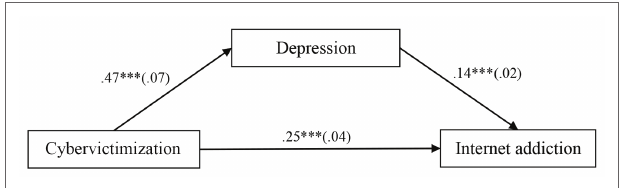
FIGURE 2 | Model of the mediating role of depression between cybervictimization and internet addiction (IA). Values are unstandardized coefficients (outside the brackets) and the standard error is enclosed in parentheses. Paths between gender, age, impulsivity, and each of the variables in the model are not displayed. Of those paths, the following were significant: gender [ b = − 0.15, SE = 0.03, 95% CI ( − 0.20, − 0.10)], age [ b = 0.07, SE = 0.02, 95% CI (0.03, 0.10)], and impulsivity [ b = 0.53, SE = 0.03, 95% CI (0.46, 0.59)] to depression; gender [ b = 0.06, SE = 0.02, 95% CI (0.03, 0.09)] and impulsivity [ b = 0.14, SE = 0.02, 95% CI (0.10, 0.18)] to IA. *** p < 0.001.